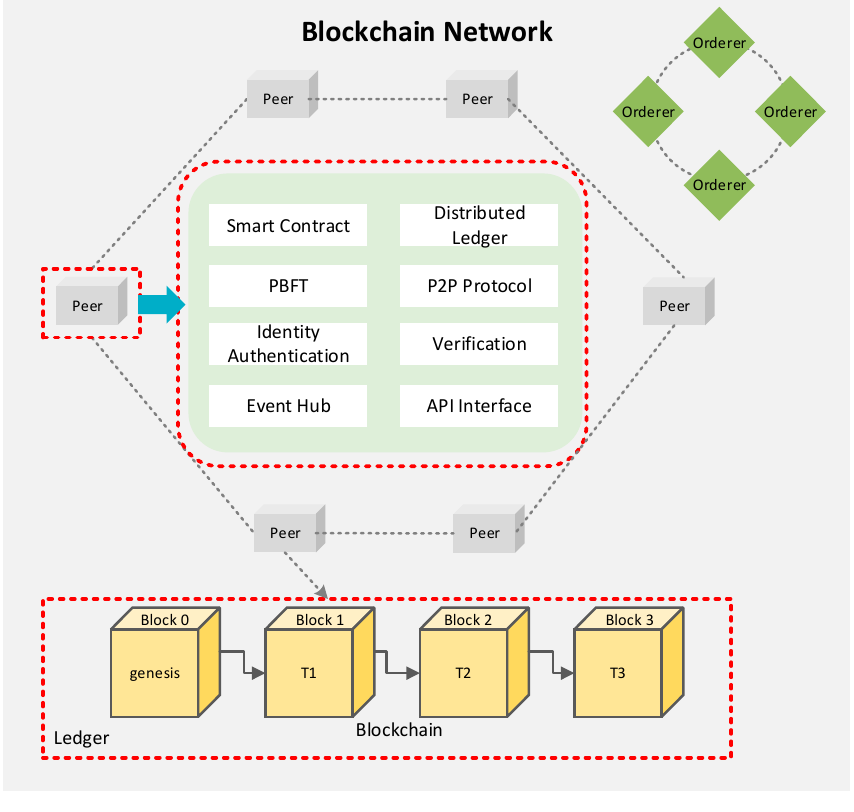
Figure 4. Blockchain network for the proposed sharing economy service.